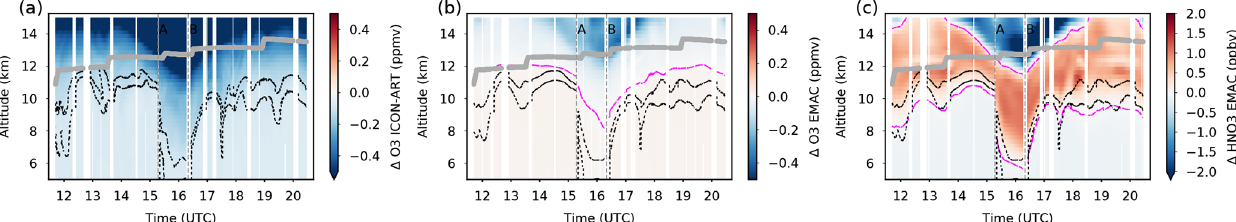
Figure 12. Modelled ozone depletion and changes in nitric acid due to chemical and microphysical processes. Residuals between (a) ICON- ART O 3 tracer and passive O 3 tracer, (b) EMAC O 3 and O 3 passive, and (c) EMAC HNO 3 and HNO 3 passive. Dashed black lines: ICON- ART and EMAC 2 and 4PVU isolines (lower and higher lines, respectively) as indicators for the dynamical tropopause. Grey lines: HALO flight altitude. Magenta lines indicate the zero